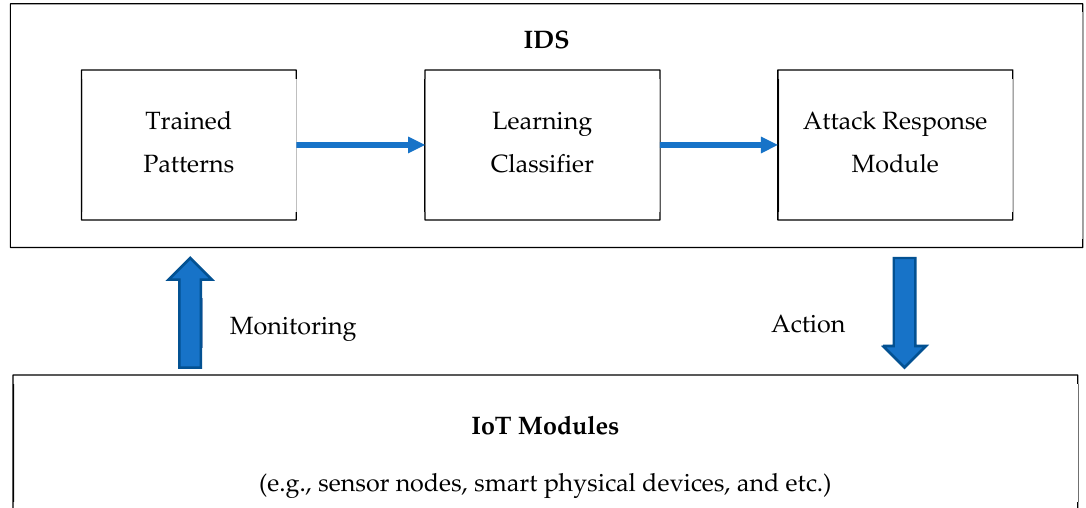
Figure 1. Typical intrusion detection system for IoT environment. IDS, intrusion detection system.